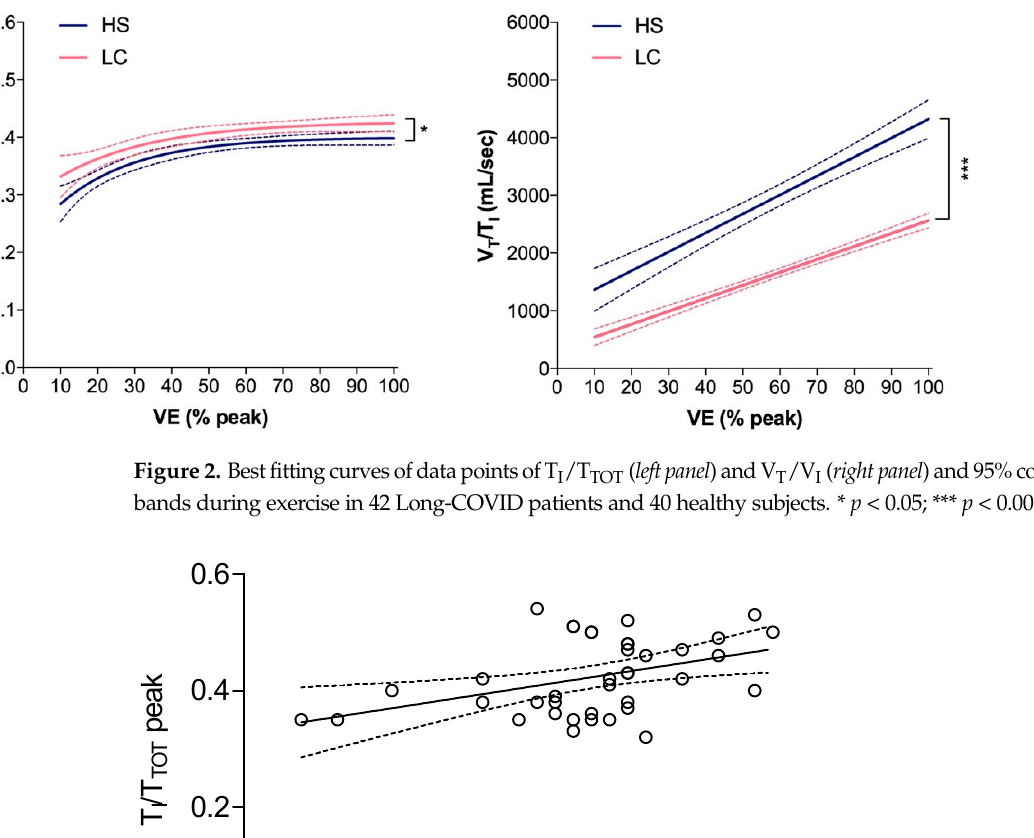
Figure 2. Best fitting curves of data points of T I /T TOT ( left panel ) and V T /V I ( right panel ) and 95% confidence bands during exercise in 42 Long-COVID patients and 40 healthy subjects. * p < 0.05; *** p < 0.001.